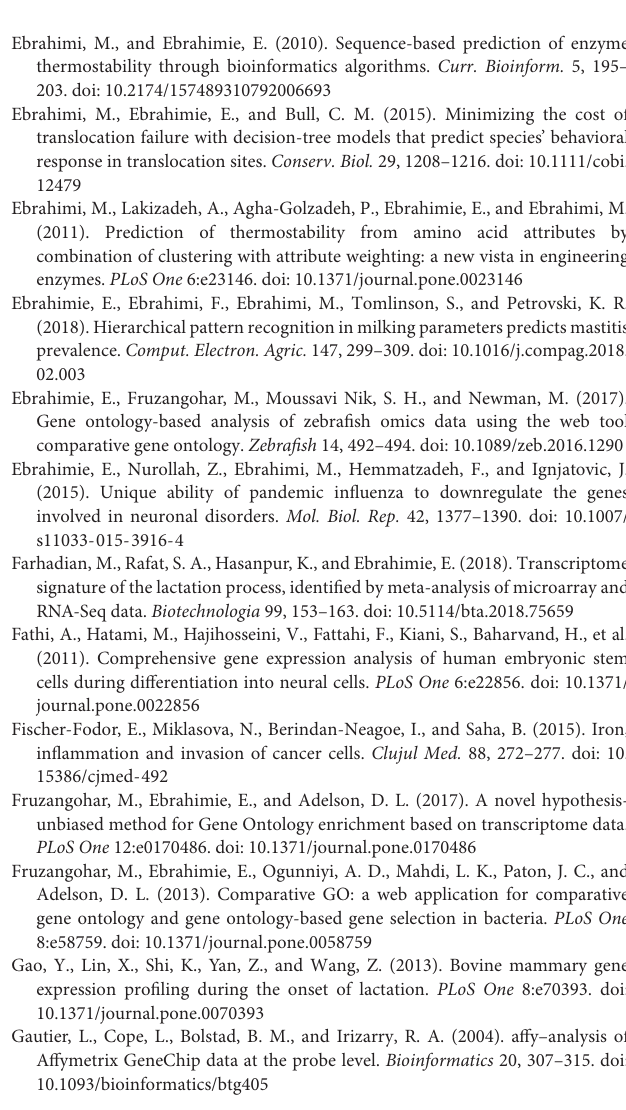
TABLE S1 | The results of application of 10 different attribute weighting algorithms for Bovine. TABLE S2 | The results of application of 10 different attribute weighting algorithms for rat. TABLE S3 | The results of application of 10 different attribute weighting algorithms for Wallaby. DATA SHEET S1 | Common genes among three different datasets. DATA SHEET S2 | Statistically significant subnetworks which can be generated by upstream genes. DATA SHEET S3 | Statistically significant subnetworks which can be generated by downstream genes.